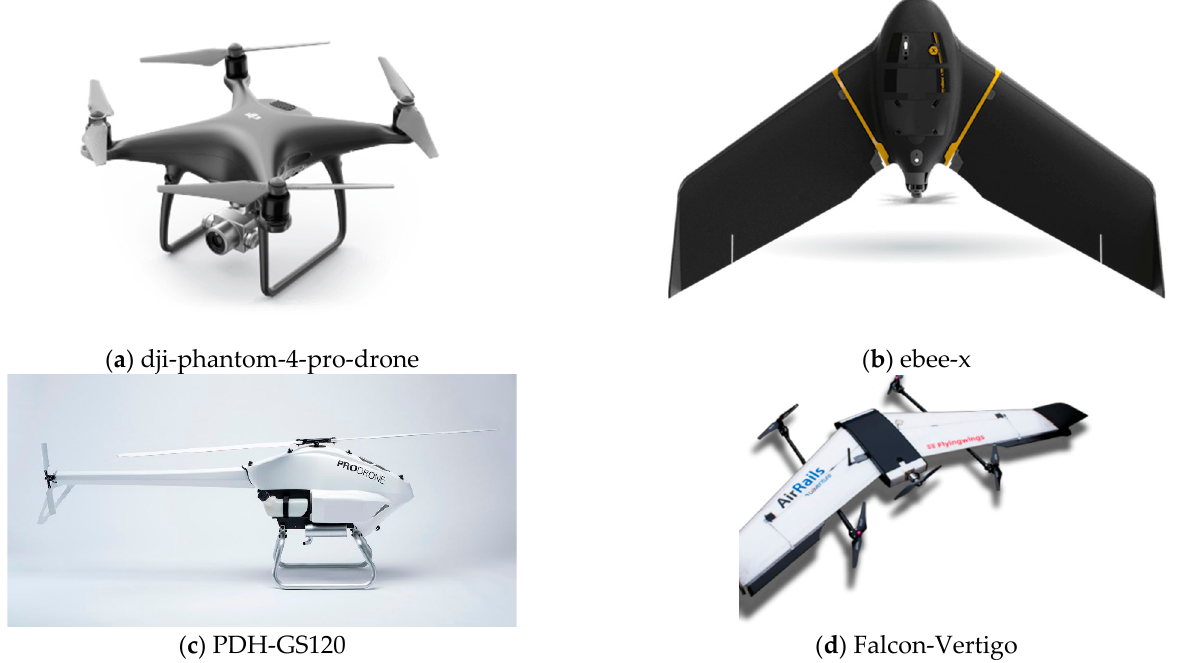
Figure 6. ( a ) multi-rotor https://www.stickpng.com/img/electronics/dji-drones/dji-phantom-4-pro- drone (accessed on 17 October 2022), ( b ) fixed-wing https://www.sensefly.com/drones/ebee-x/ (ac-